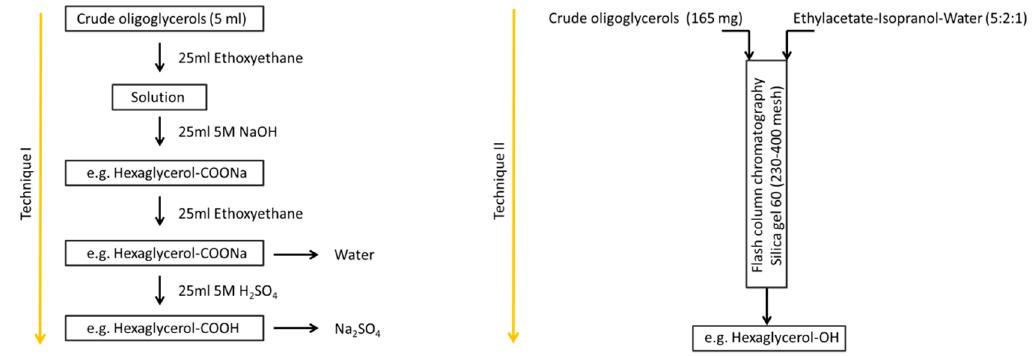
Figure 2. An exemplary scheme for the purification of oligoglycerols .